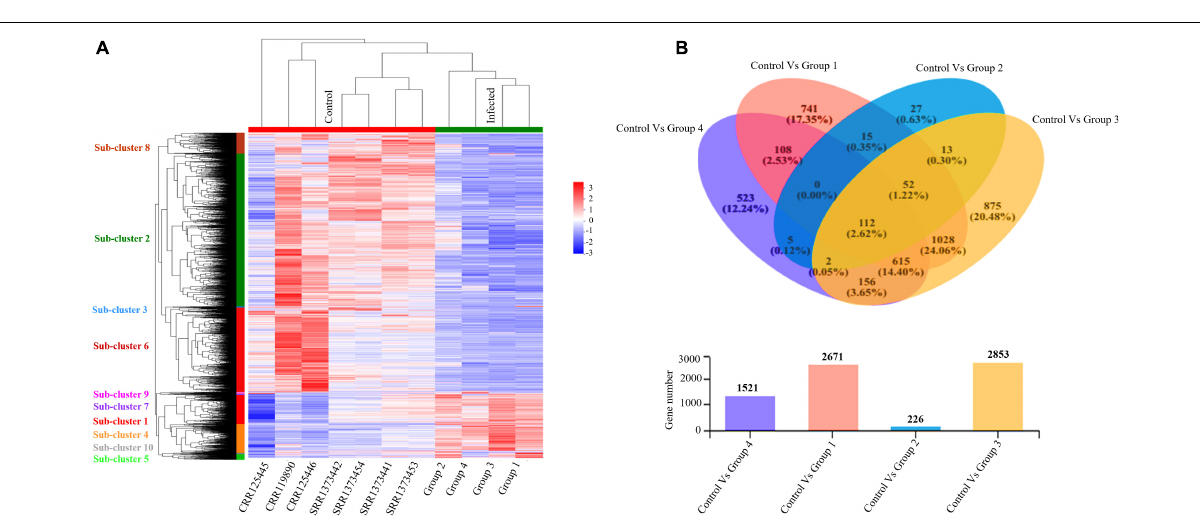
FIGURE 4 | Altered transcriptome profiles across COVID-19 severities. (A) Hierarchal clustering Heat map for significantly upregulated and downregulated DEGs (fold change (log2FC ≥ 2) in COVID-19 PBMC samples compared to controls. The negative numbers having blue color indicate down-regulated genes, and the positive numbers with red color indicate upregulated genes. The sub-cluster labels on the Y-axis are added manually and specified by their corresponding color in the heat map. (B) Venn Diagram Analysis: Venn diagram of the healthy control cohort and each patient’s group. Circles with different colors represent the four infected Groups, and the number of genes/transcripts screened based on expression levels in each sample/group compared to the control cohort. The individual and overlapping portions in the Venn diagram illustrating the number of explicitly expressed and co-expressed genes among different